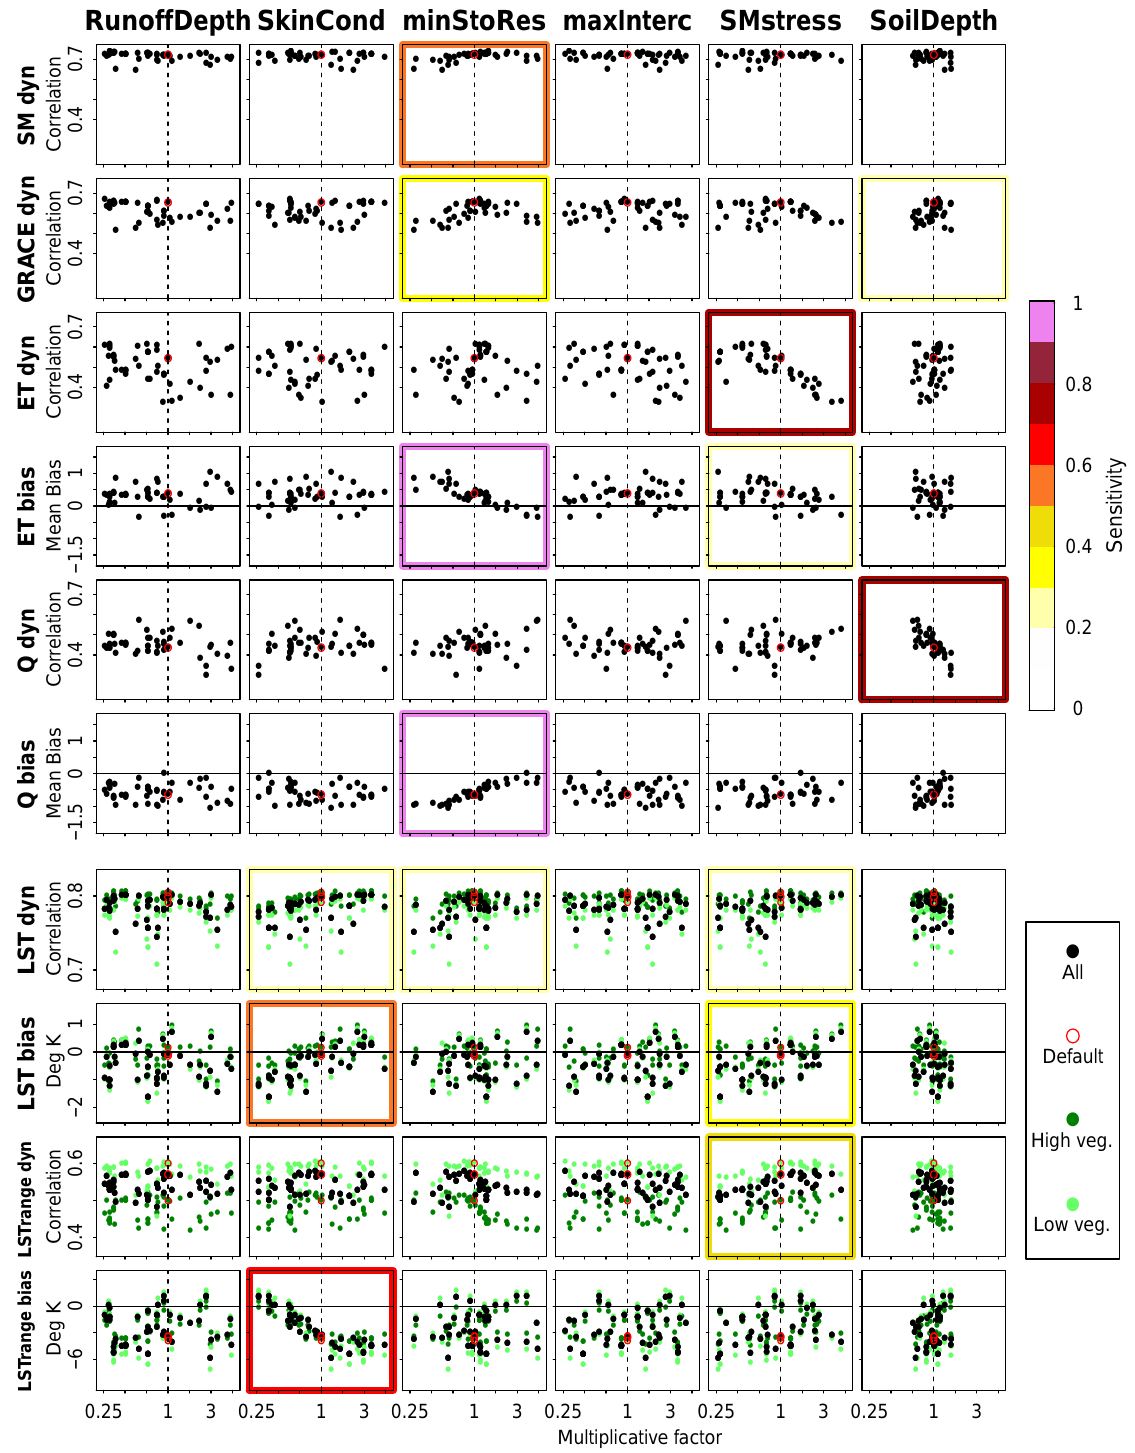
Figure 2. Variations of HTESSEL performance (averaged over the European domain) in terms of anomaly correlations and biases against several reference datasets ( y -axis) in response to variations in poorly constrained model parameters ( x -axis). The colour of each box indicates the sensitivity of the HTESSEL performance in terms of a particular metric against a particular parameter. Red circles indicate results for the default HTESSEL calibration, and green circles denote results for areas with low/high vegetation